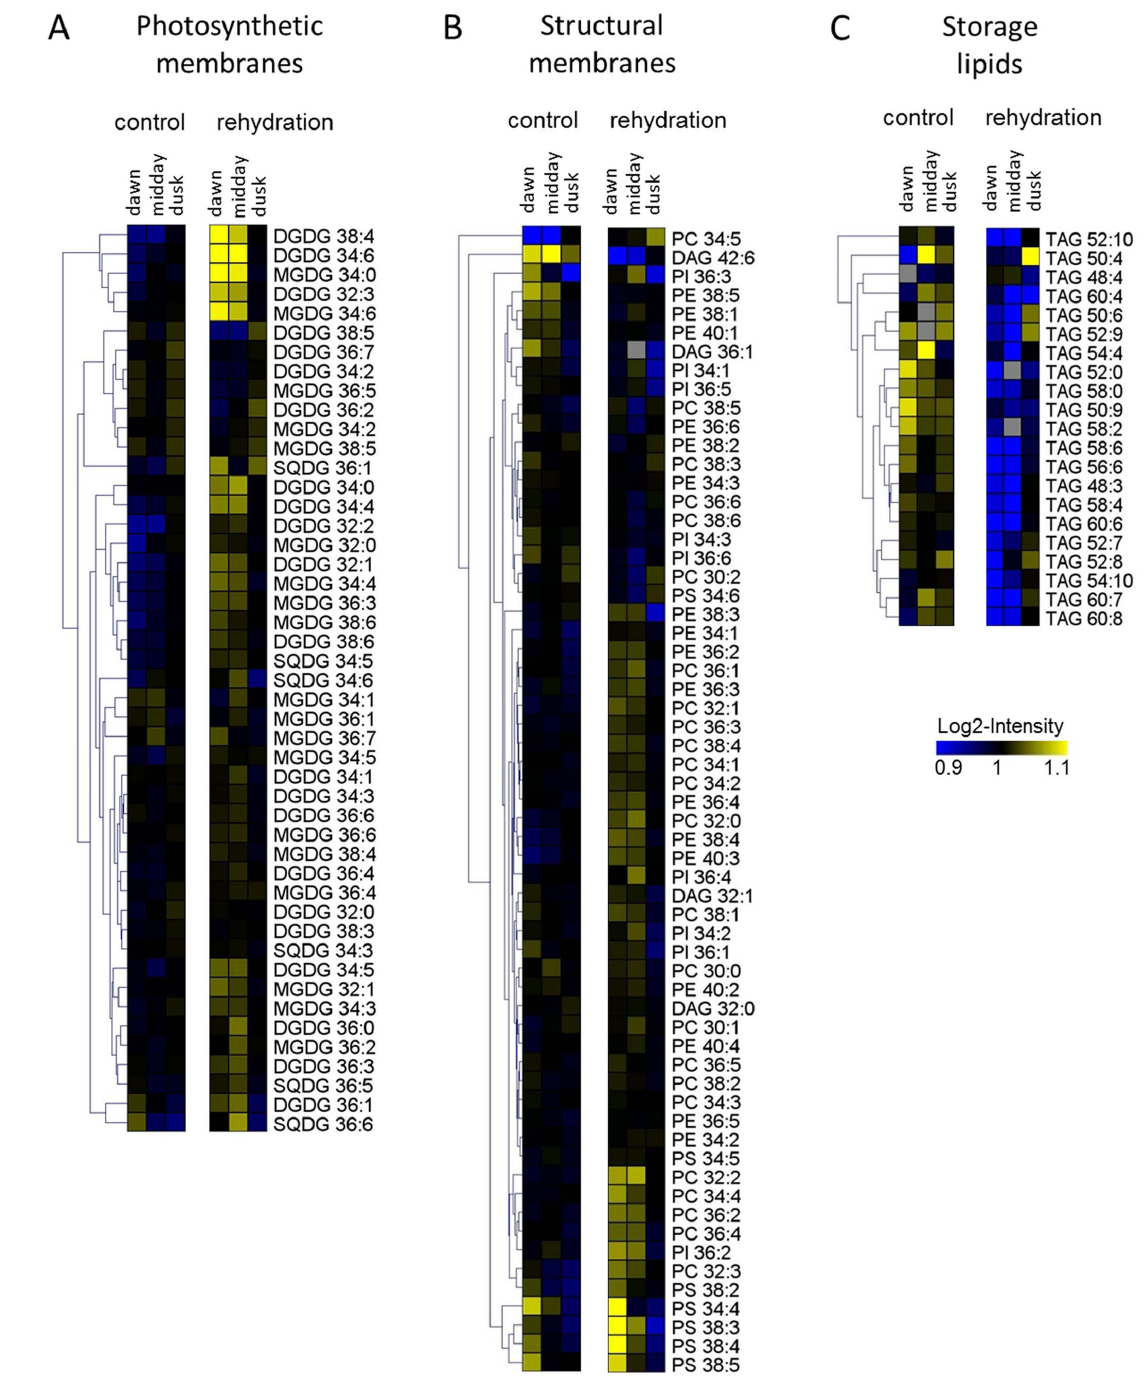
Figure 4. Clustered heatmap visualization of different lipid classes. Shown is the average abundance of several complex lipids visualized in a false-color heatmap at the three time points before and after watering ordered according to their presence in photosynthetic membranes, in cellular membranes or representing storage lipids.